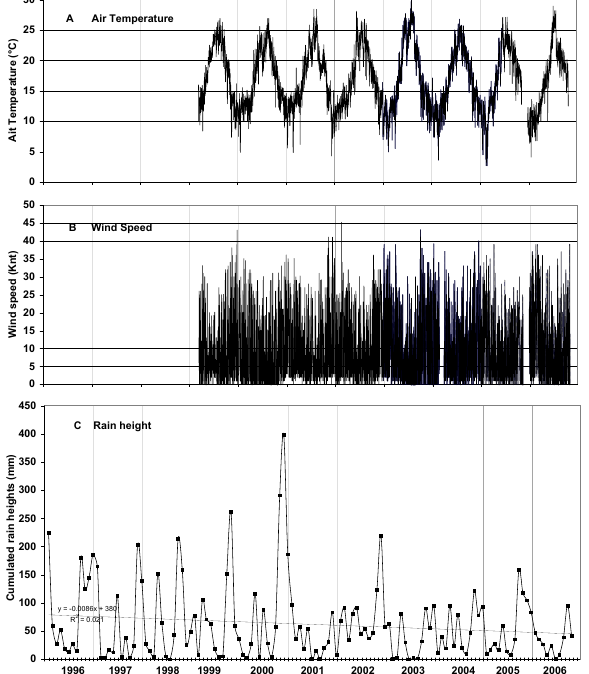
Fig. 6. (A) Air temperature ( ◦ C); data from the meteorological “Cˆote d’Azur” buoy. (B) Wind speed (Knt); data from the meteoro- logical “Cˆote d’Azur” buoy. (C) Monthly cumulated precipitation heights (mm) during the 1996–2006 period; data from a meteoro- logical station boarding the Ligurian Sea (Nice airport).